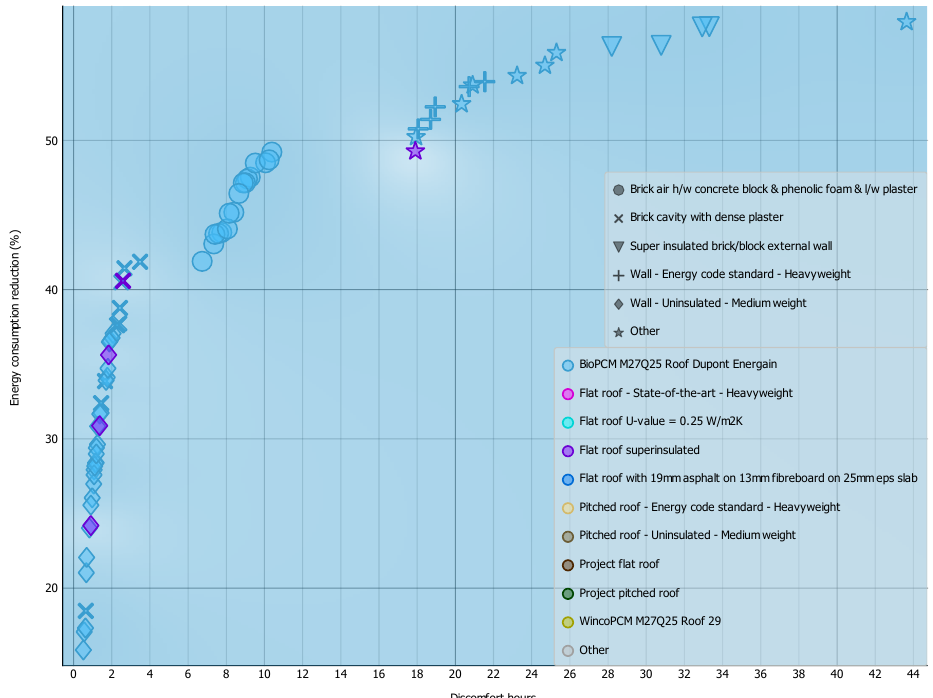
Figure 10. Results of energy consumption reduction (%) for cooling at Pareto’s front for the H200.